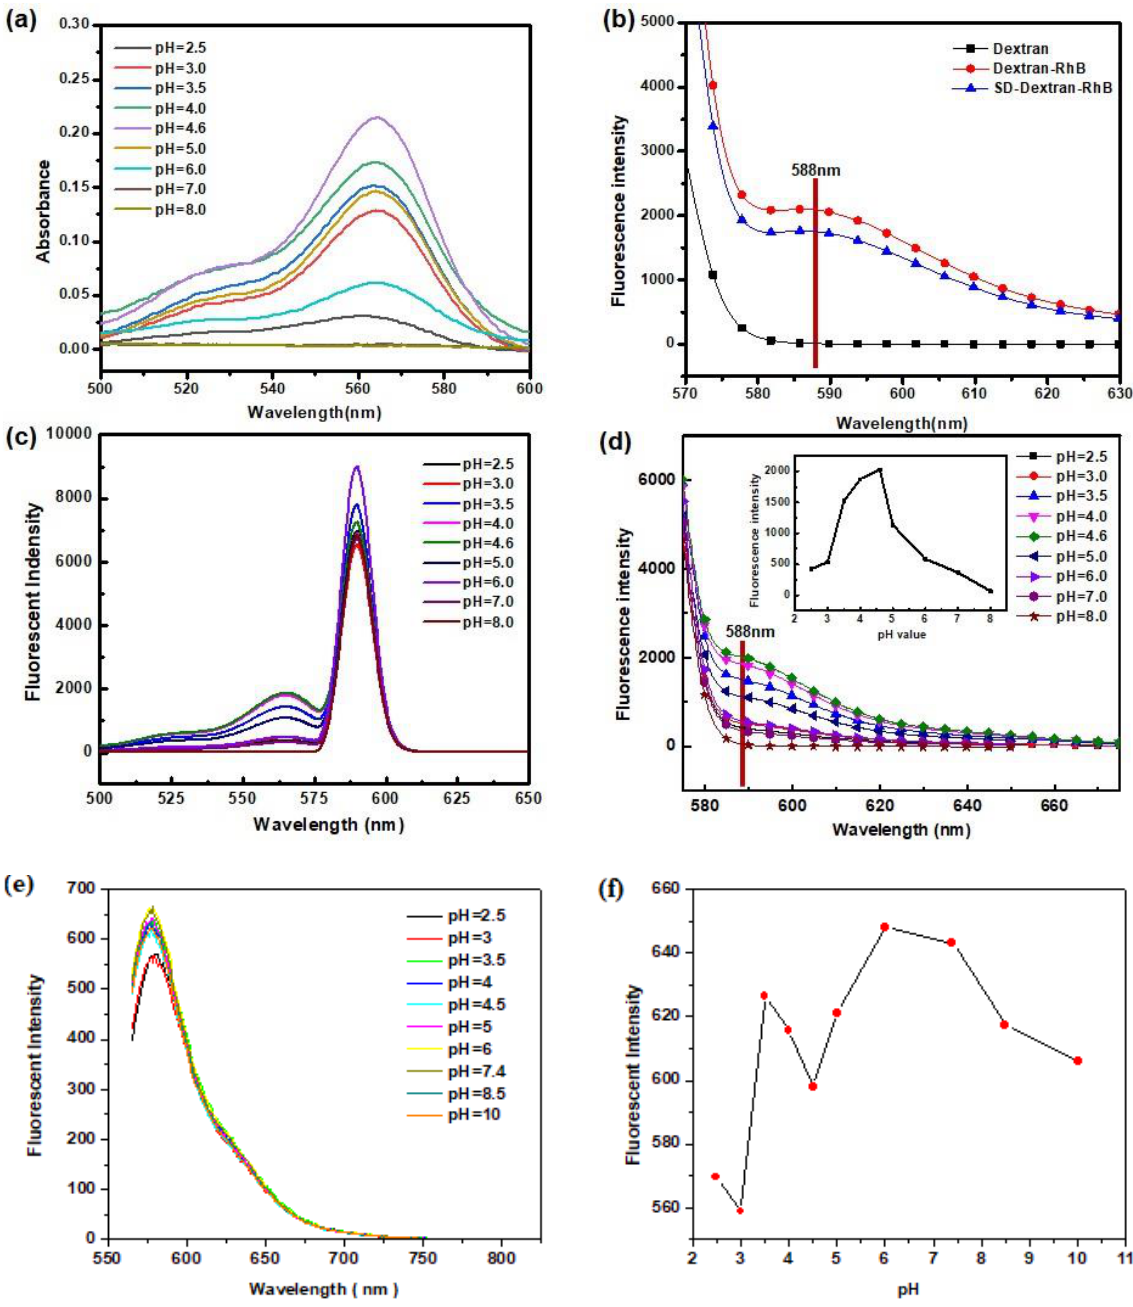
Figure 4. UV spectra ( a ), fluorescent spectra ( b ), fluorescent excitation spectra ( c ), and fluorescence emission spectra ( d ) of SD-Dextran-RhB and fluorescent excitation spectra ( e , f ) of RhB in different acidic conditions.